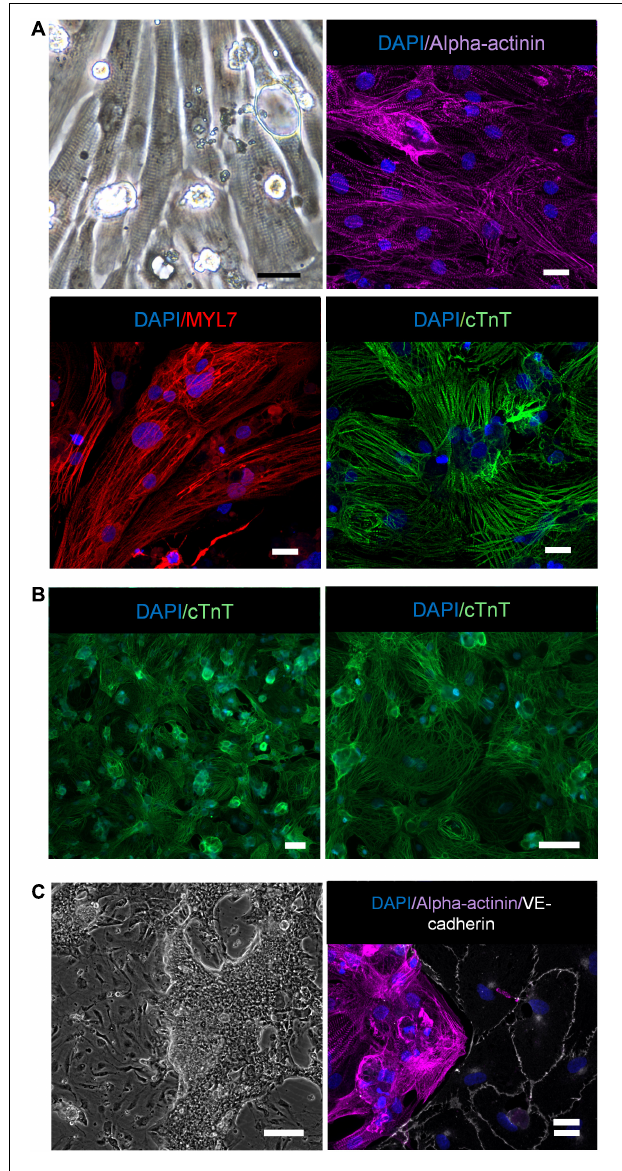
FIGURE 1 | CM characterization. (A) Light-microscope image of hiPS-CMs (scale bar 25 µ m), immunofluorescence staining of hiPS-CMs with alpha-actinin, MYL7 and cTnT (scale bar 20 µ m). (B) Images at lower magnification illustrate the purity of the CM population (scale bar 50 µ m). (C) Light microscope image of hiPS-EC and hiPS-CM co-culture (scale bar 200 µ m), immunofluorescence staining hiPS-EC and hiPS-CM co-culture with alpha-actinin and VE-cadherin (scale bar 20 µ